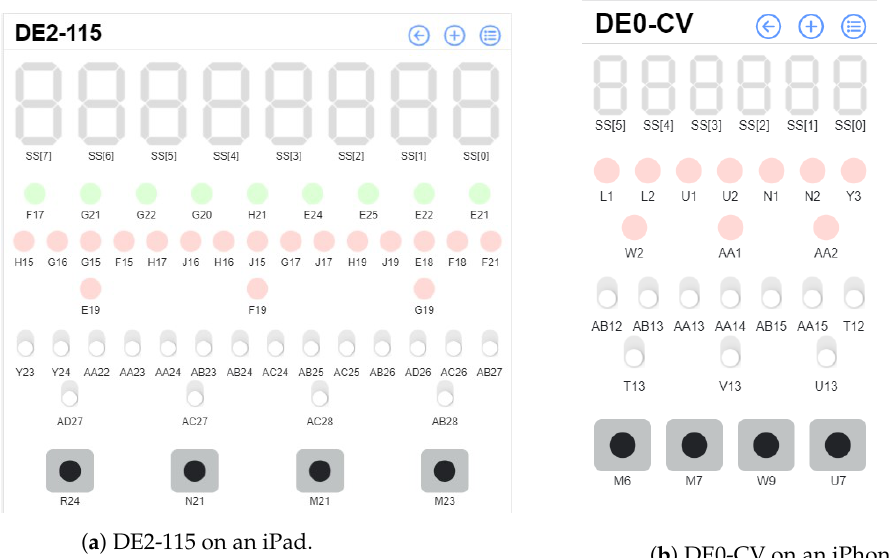
Figure 5. Development board view on various